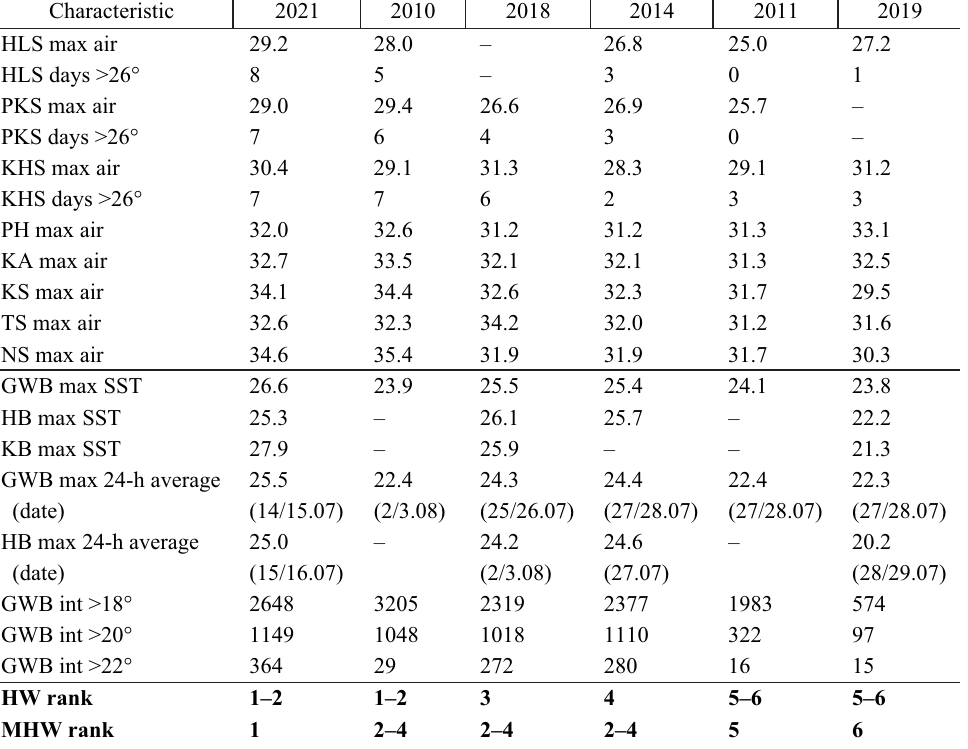
Table 2. Characteristics and ranking of the summer HWs and MHWs in the Gulf of Finland area; daily maximum air temperatures and the number of days with maxima over 26 °C at the HLS, PKS and KHS (see Fig. 1 for station codes); maximum air temperatures at the PH, KA, KS, TS and NS. Absolute maximum water temperatures (SST), maximum 24-h averages and integral values (int; in degree-hours) over the bases of 18, 20 and 22 °C calculated at the GWB, HB and KB. Based on rankings of individual characteristics, the aggregate ranks (for HW, MHW) are (somewhat subjectively) grouped and